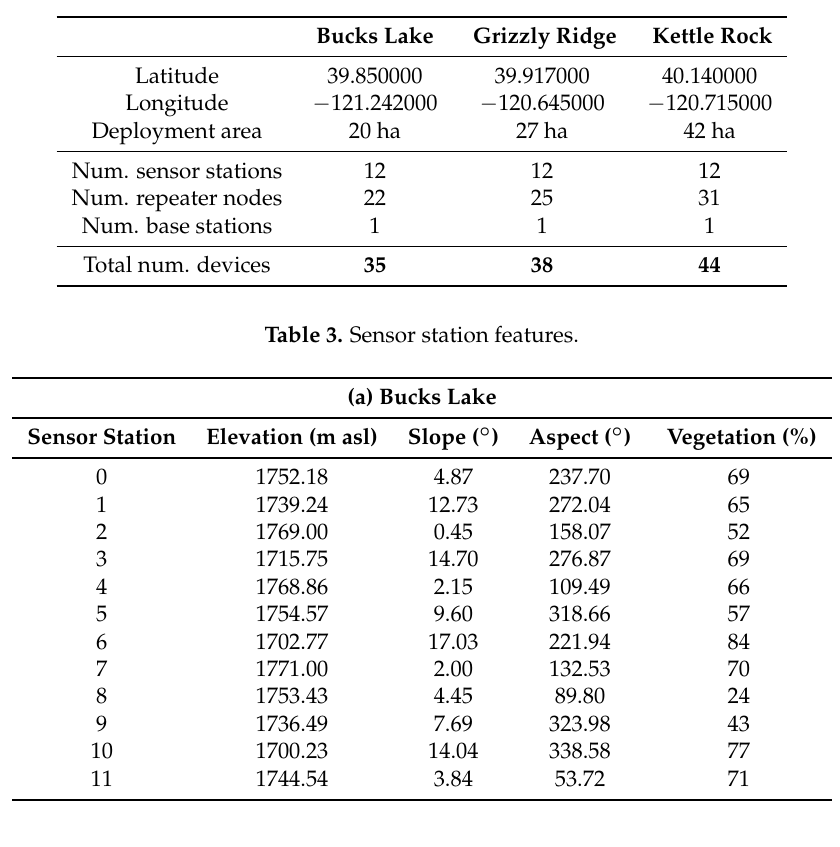
Table 2. Location and size of deployments.